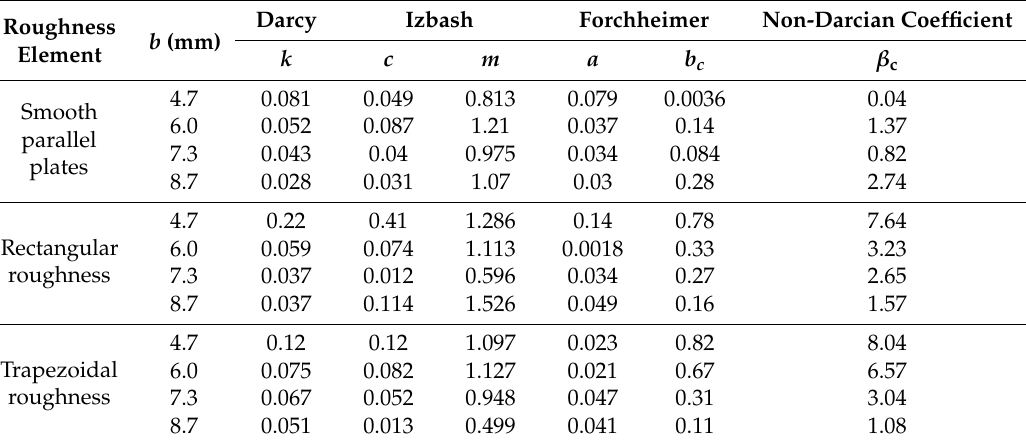
Table 6. Fitting parameters of non-Darcian